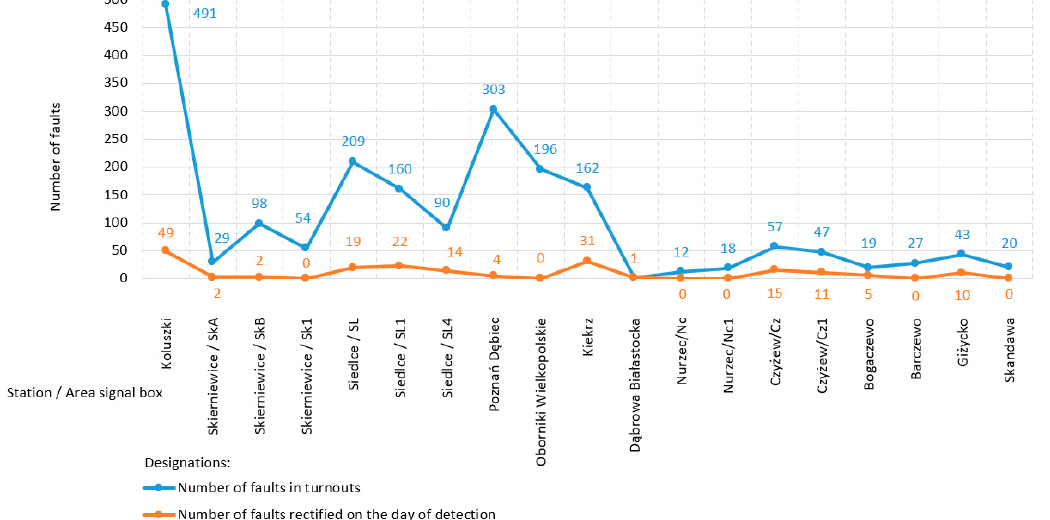
Figure 8. Status of the number of faults in turnouts in selected stations/area signal boxes.